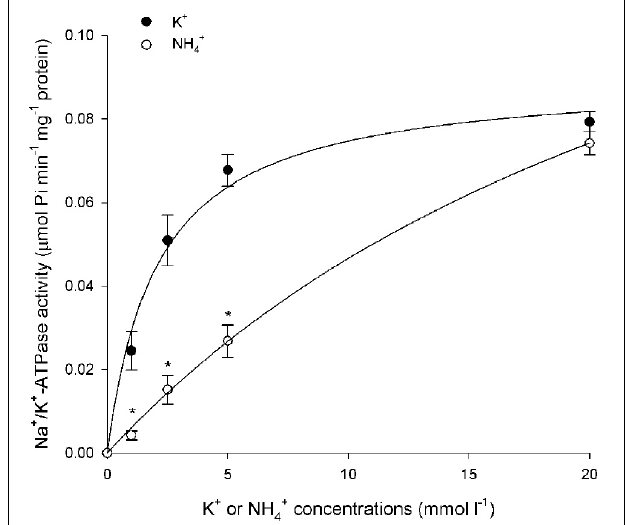
FIGURE 1 | Effects of varying K + or NH + 4 concentrations on branchial Na + /K + -ATPase (Nka) activity. Specific activity ( μ mol Pi min − 1 mg − 1 protein) of Nka from the gills of Periophthalmodon schlosseri pre- acclimated to slightly brackish water (SBW; salinity 3) for 2 weeks (control) with varying concentrations of K + or NH + 4 . Results represent mean ± s.e.m. ( N = 4). ∗ Significant difference from the corresponding K + -induced specific activity ( P < 0 .